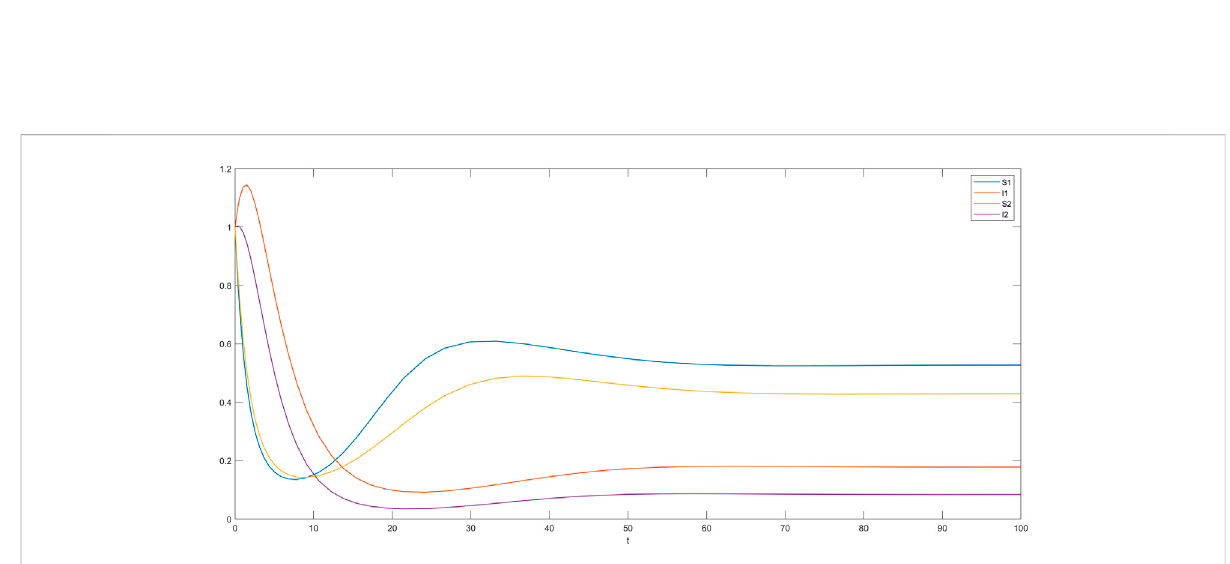
FIGURE 2 Stability of panic-permanent equilibrium when R 0 >